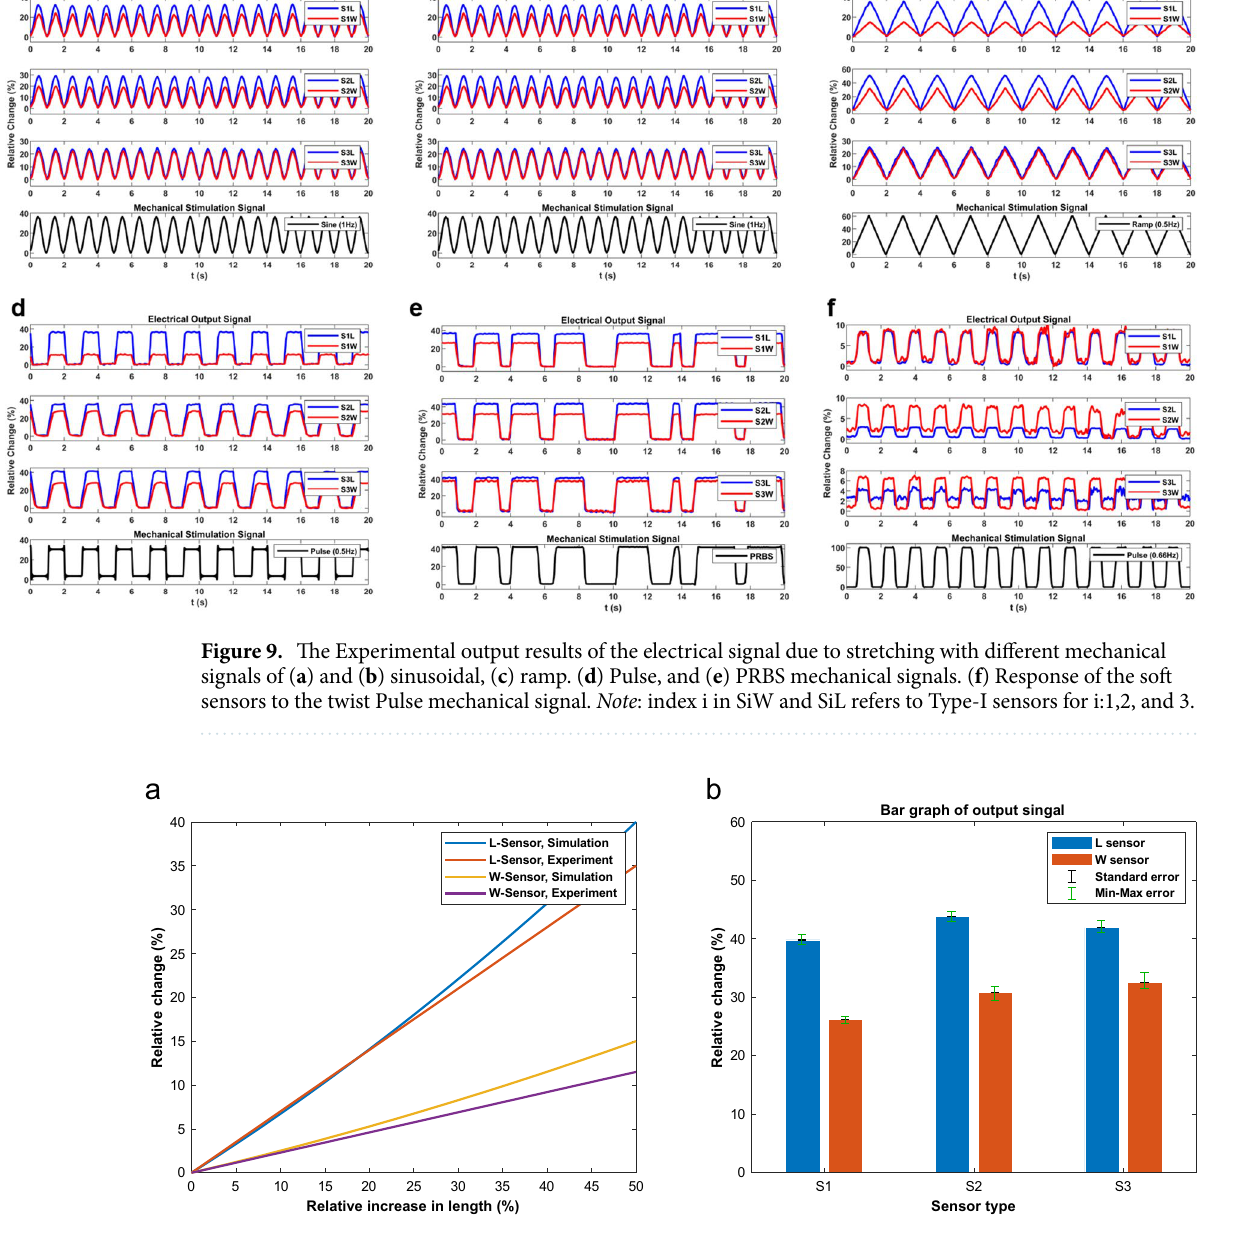
Figure 10. ( a ) Comparison of simulation and experimental results for sensor Type-2. ( b ) Bar graph of output signal strength including error (Fig. 11a). The setup contains a digital scale and a beaker stand and a piece of aluminum sheet was fixed under the horizontal bar of the stand. Afterward, a digital scale was placed near the stand, and the Soft Sensor was put on the scale. By turning the screw on the beaker stand, the height of the aluminum sheet would change, and after it reaches the surface of the Soft Sensor, it would start applying force in the Z direction on the Soft Sensor. The digital scale was used to measure the amount of force applied to each point. Though, the screw on the stand was turned until the aluminum sheet touched the surface of the Soft Sensor and started applying pressure on it until the digital scale showed the number of 300gr, which is equal to ~ 3 N force. In order to calculate the pressure applied to the soft sensor, the following equation could be used: F (8) P = A where F is the applied force and A is the area of contact. As previously stated, the applied force in this experi- ment is ~ 3 N. The sheet was 2 mm thick and 20 mm long, resulting in a surface area of 40 mm 2 . Consequently,